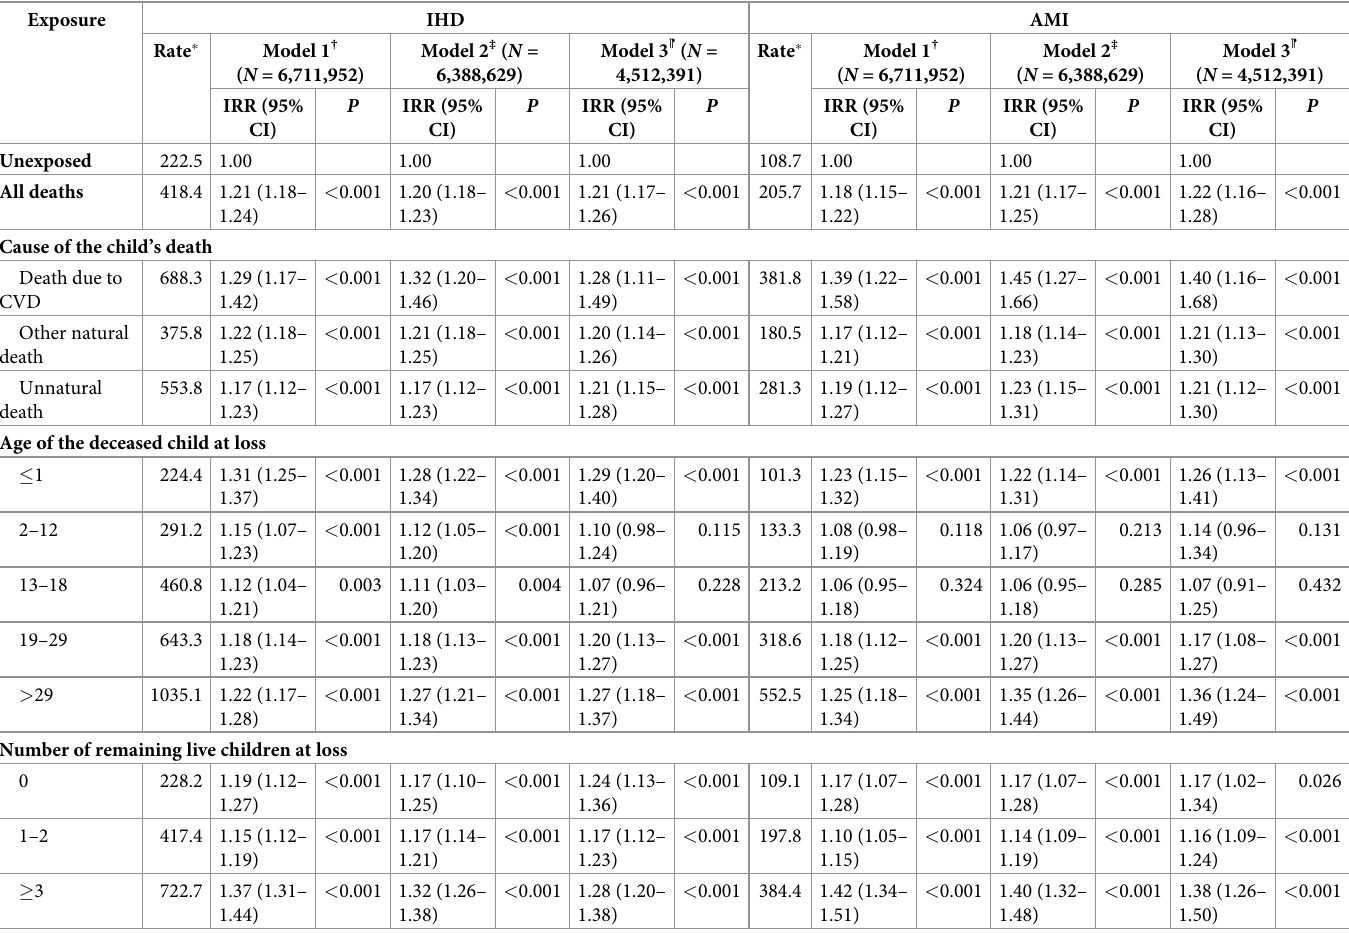
Table 2. Adjusted IRRs and 95% CIs for IHD according to the death of a